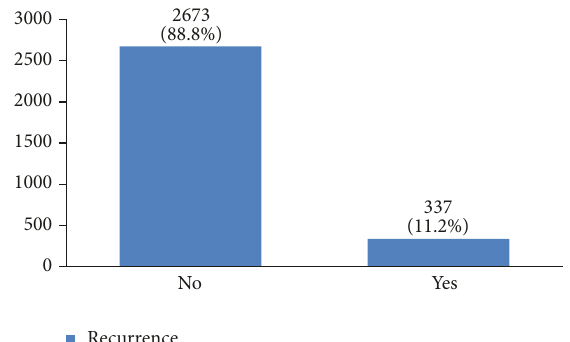
Figure 33: The percentage of recurrence in the studied cases.